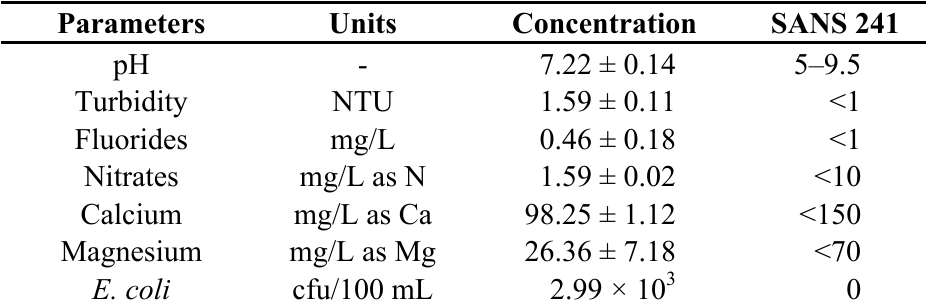
Table 2. Characteristics of groundwater